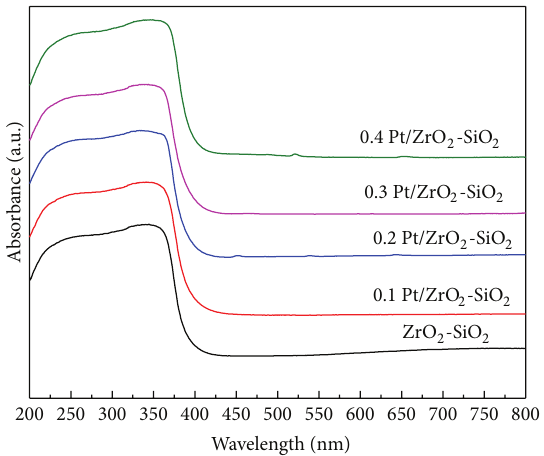
Figure 4: UV-Vis absorption spectra of ZrO 2 -SiO 2 and various combinations of Pt/ZrO 2 -SiO 2 .